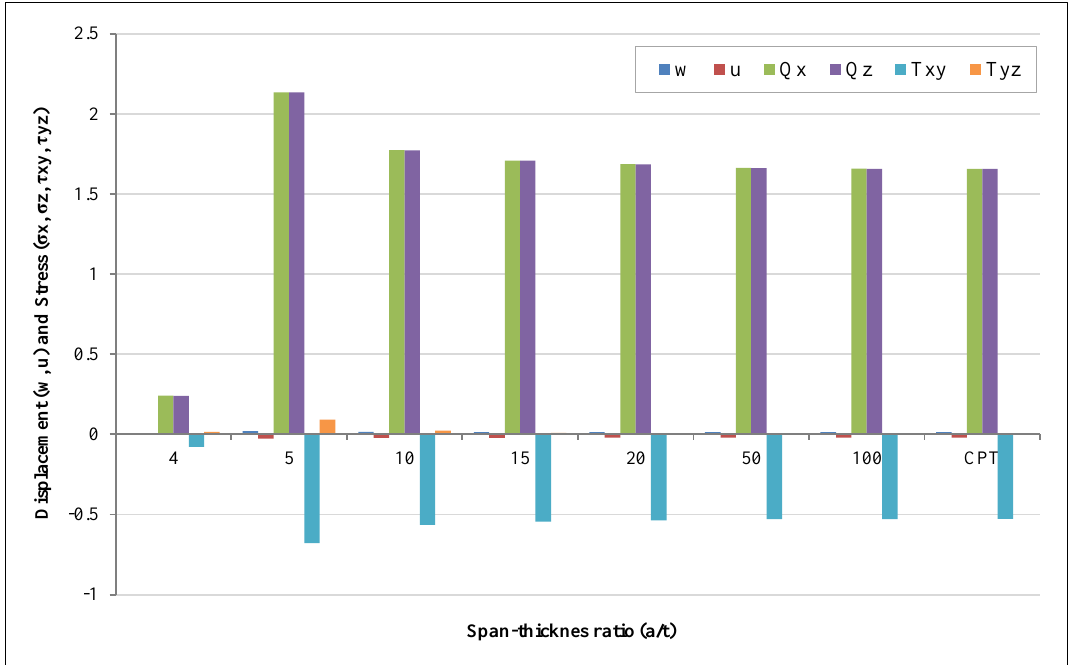
Figure 6. The result of displacements and stresses of a clamped square